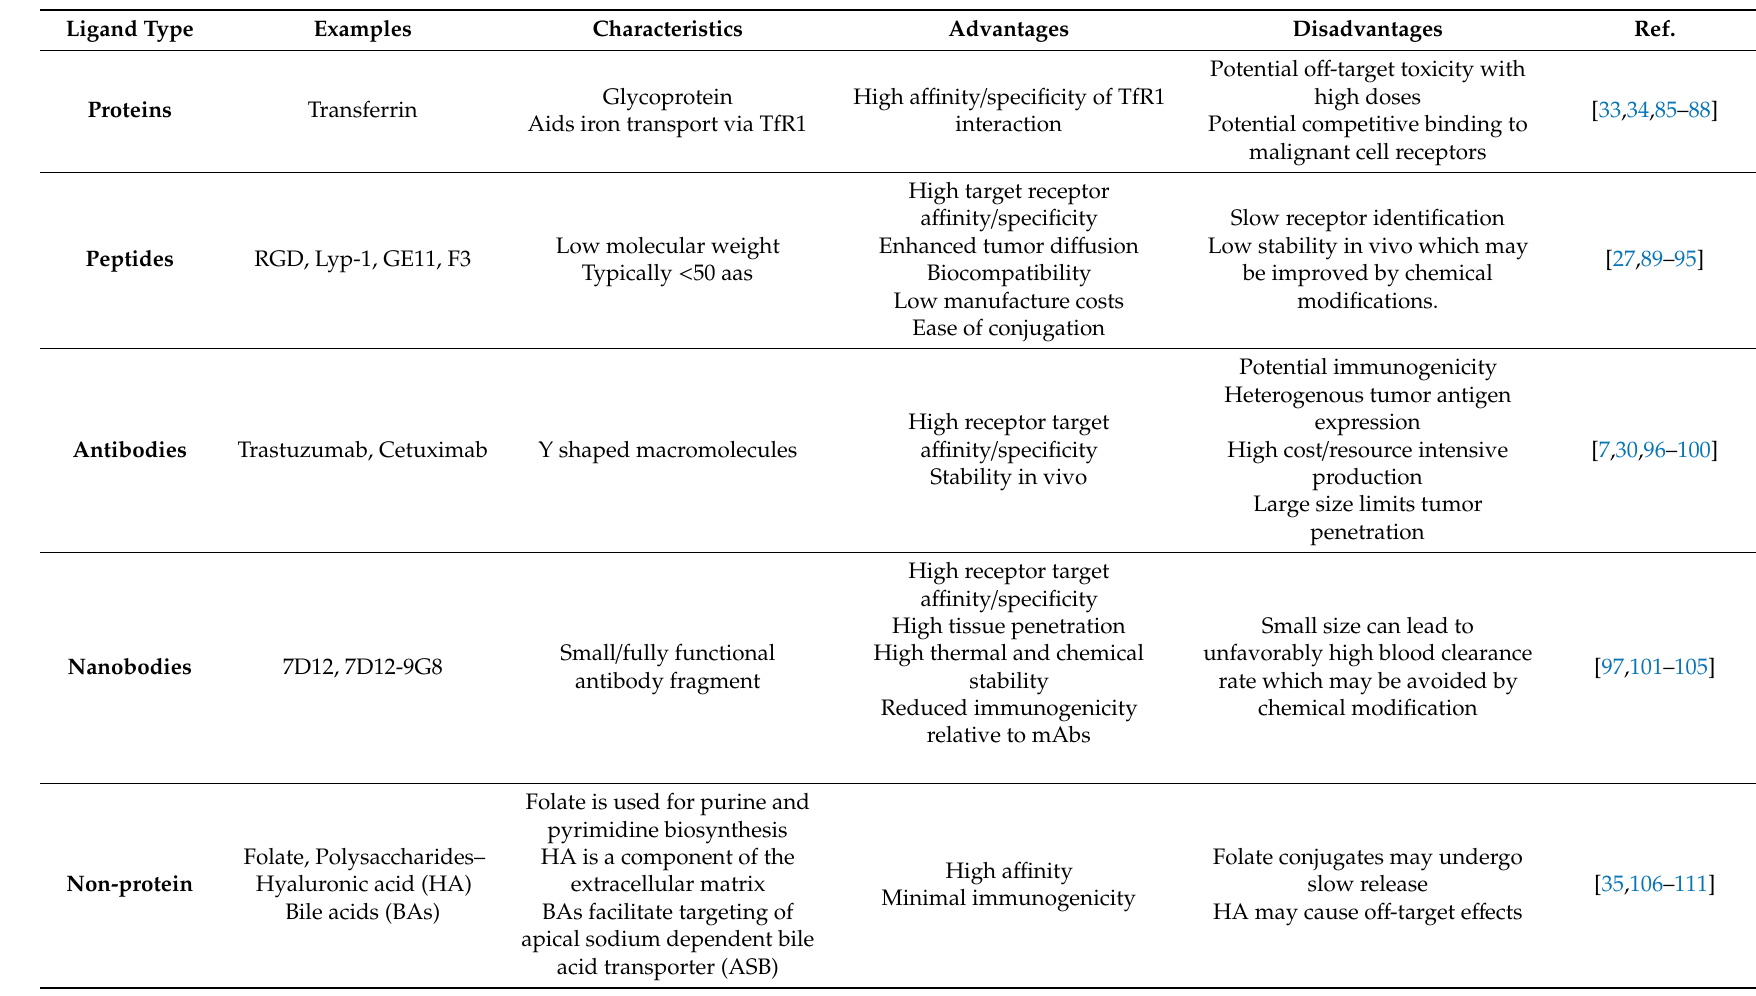
Table 2. Ligands for active